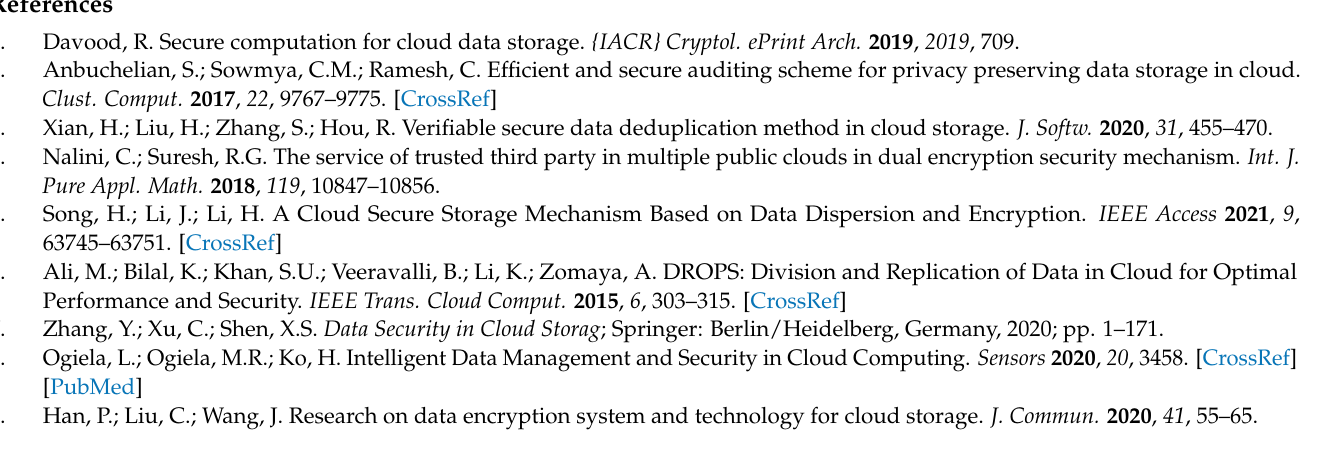
Figure 11. Comparison of file download times in two protocols.